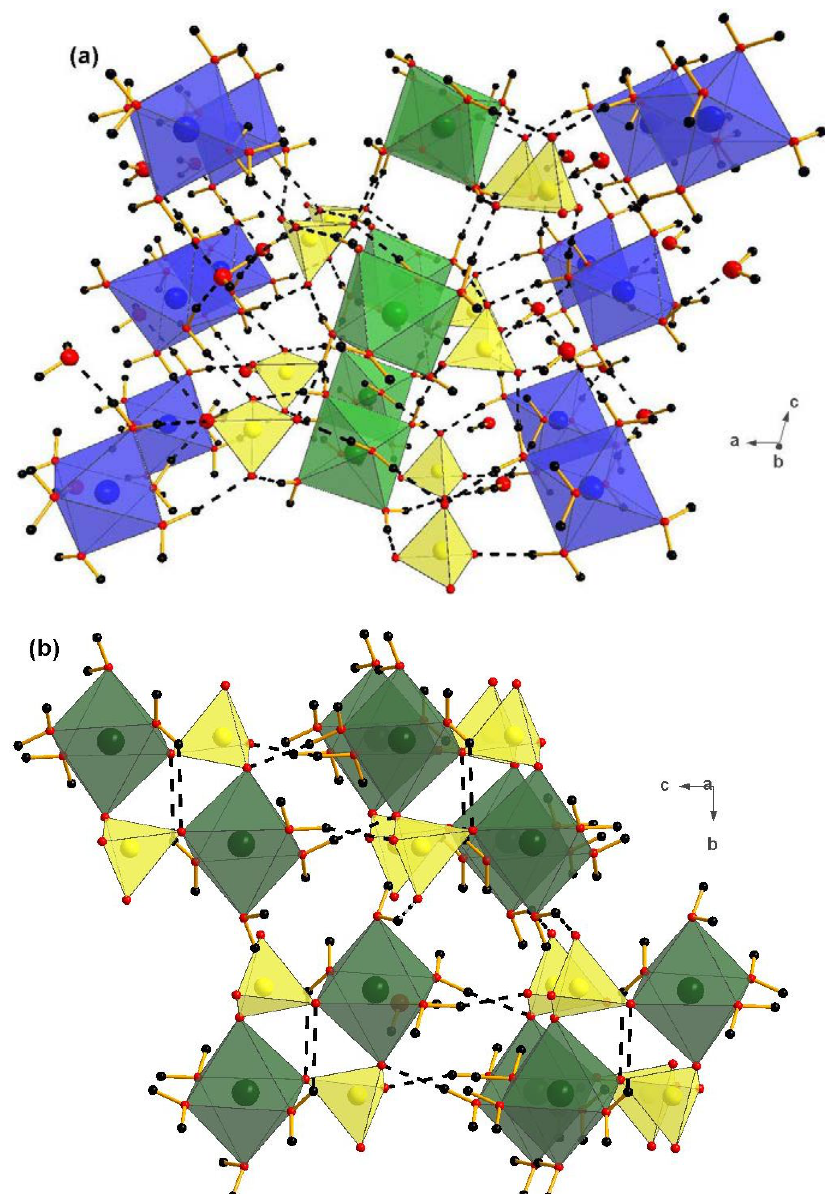
Figure 8. The crystal structure of ( a ) melanterite, and ( b ) rozenite. H-bonds to sulfate tetrahedra are indicated by dashed black lines. Symbols: green polyhedra = M1-Fe site, blue polyhedra = M2-Fe site, dark green = Fe site, yellow polyhedra = S site. Red, and black circles represent O, and H sites, respectively. The transition from melanterite to rozenite with the temperature is accomplished by replacing the H 2 O groups with oxygens belonging to different SO 4 groups (see text).